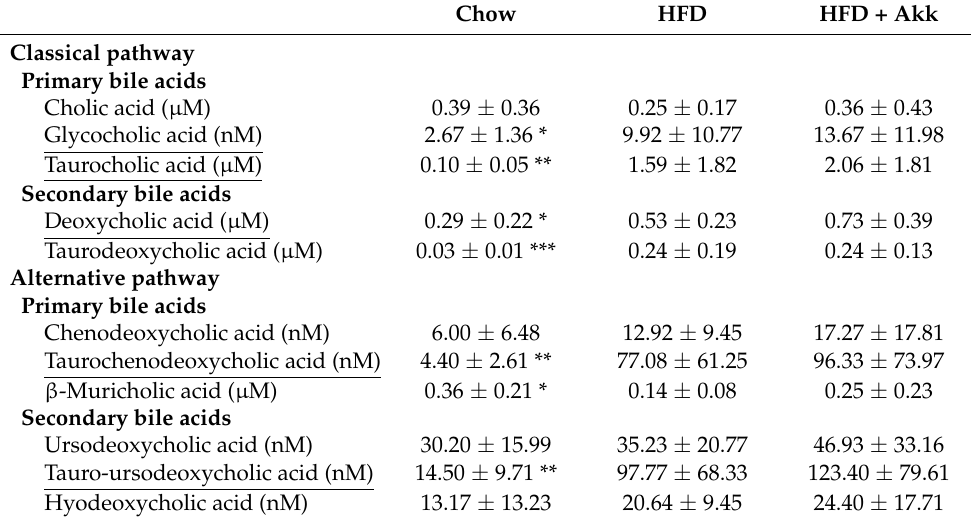
Table 3. Plasma bile acids are not affected by heat-inactivated A. muciniphila .